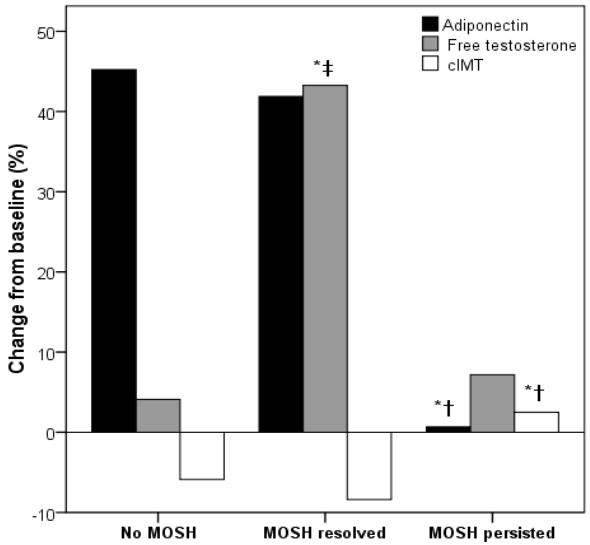
Figure 1. Changes in circulating adiponectin, free testosterone (FT), and carotid intima-media thickness (cIMT) in the included men depending on the presence of MOSH and its resolution. * p < 0.05 vs. no MOSH, † p < 0.05 vs. MOSH resolved, ‡ p < 0.05 vs. MOSH persisted. Regarding other changes after the intervention (Table 2), patients with persistence of MOSH showed lower EWL than the other two groups (F = 3.683, p = 0.031), whereas diastolic BP was lower after MOSH resolution (F = 4.680, p = 0.013). Conversely, changes between the three groups in systolic BP, LDL, HDL, glycemia, insulin, and HOMA-IR were not significant (F = 0.866, p = 0.426; F = 0.447, p = 0.642; F = 0.506, p = 0.606; F = 1.135, p = 0.329; F = 0.259, p = 0.772; and F = 2.330, p = 0.106, respectively) (Table